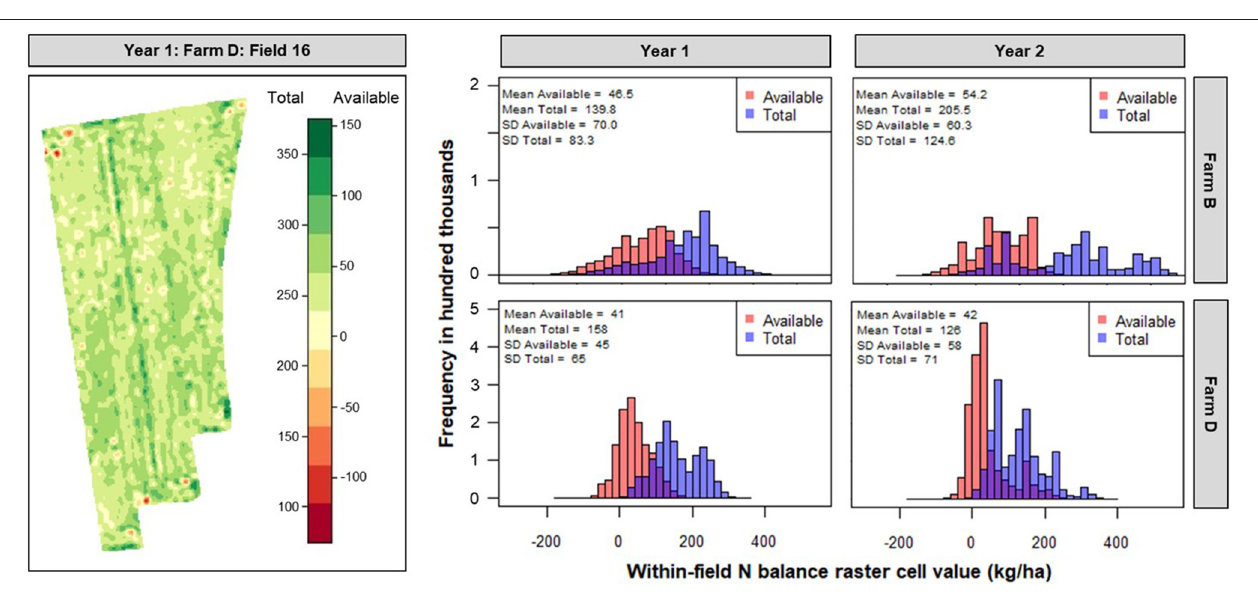
from − 146 to 179 and − 90 to 321 kg N ha − 1 with means 36 ± 40 and 141 ± 58 kg N ha − 1 , respectively while in year 2, the balances ranged from − 157 to 252 and − 101 to 387 kg N ha − 1 with an average of 37 ± 52 and 113 ± 63 kg N ha − 1 ,